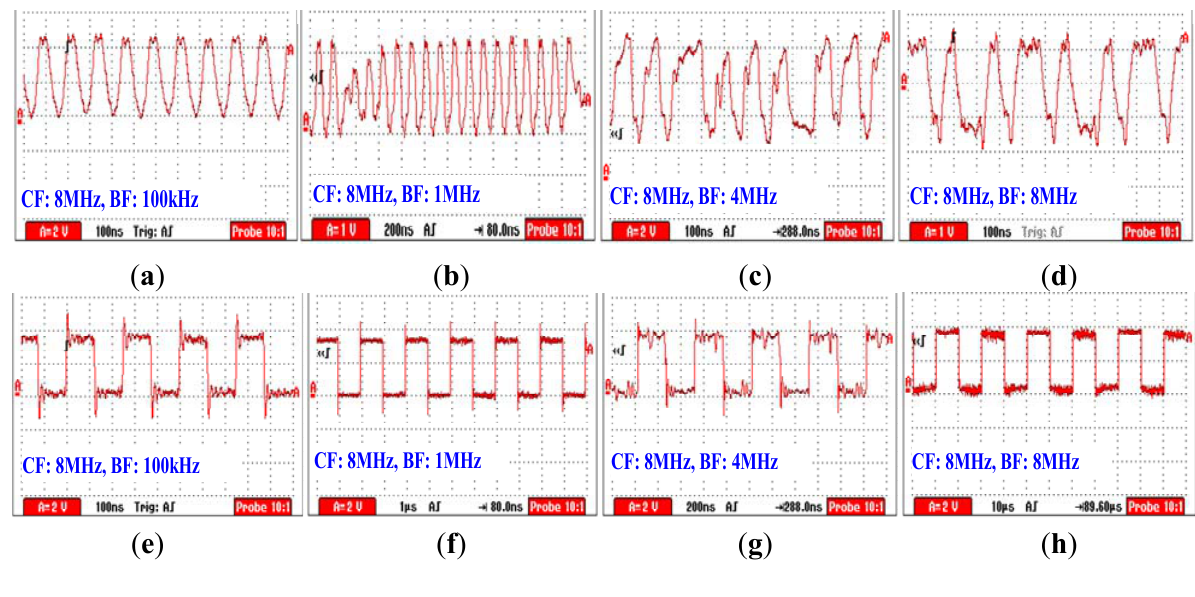
Figure 9. The modulated signal received by the Mach-Zehnder EO sensor on the conditions that CF = 8 MHz and BF is ( a ) 100 kHz, ( b ) 1 MHz, ( c ) 4 MHz and ( d ) 8 MHz, respectively. Figure ( e , f , g , h ) are the corresponding demodulated signals of the modulated signal shown in Figure ( a , b , c , d ),